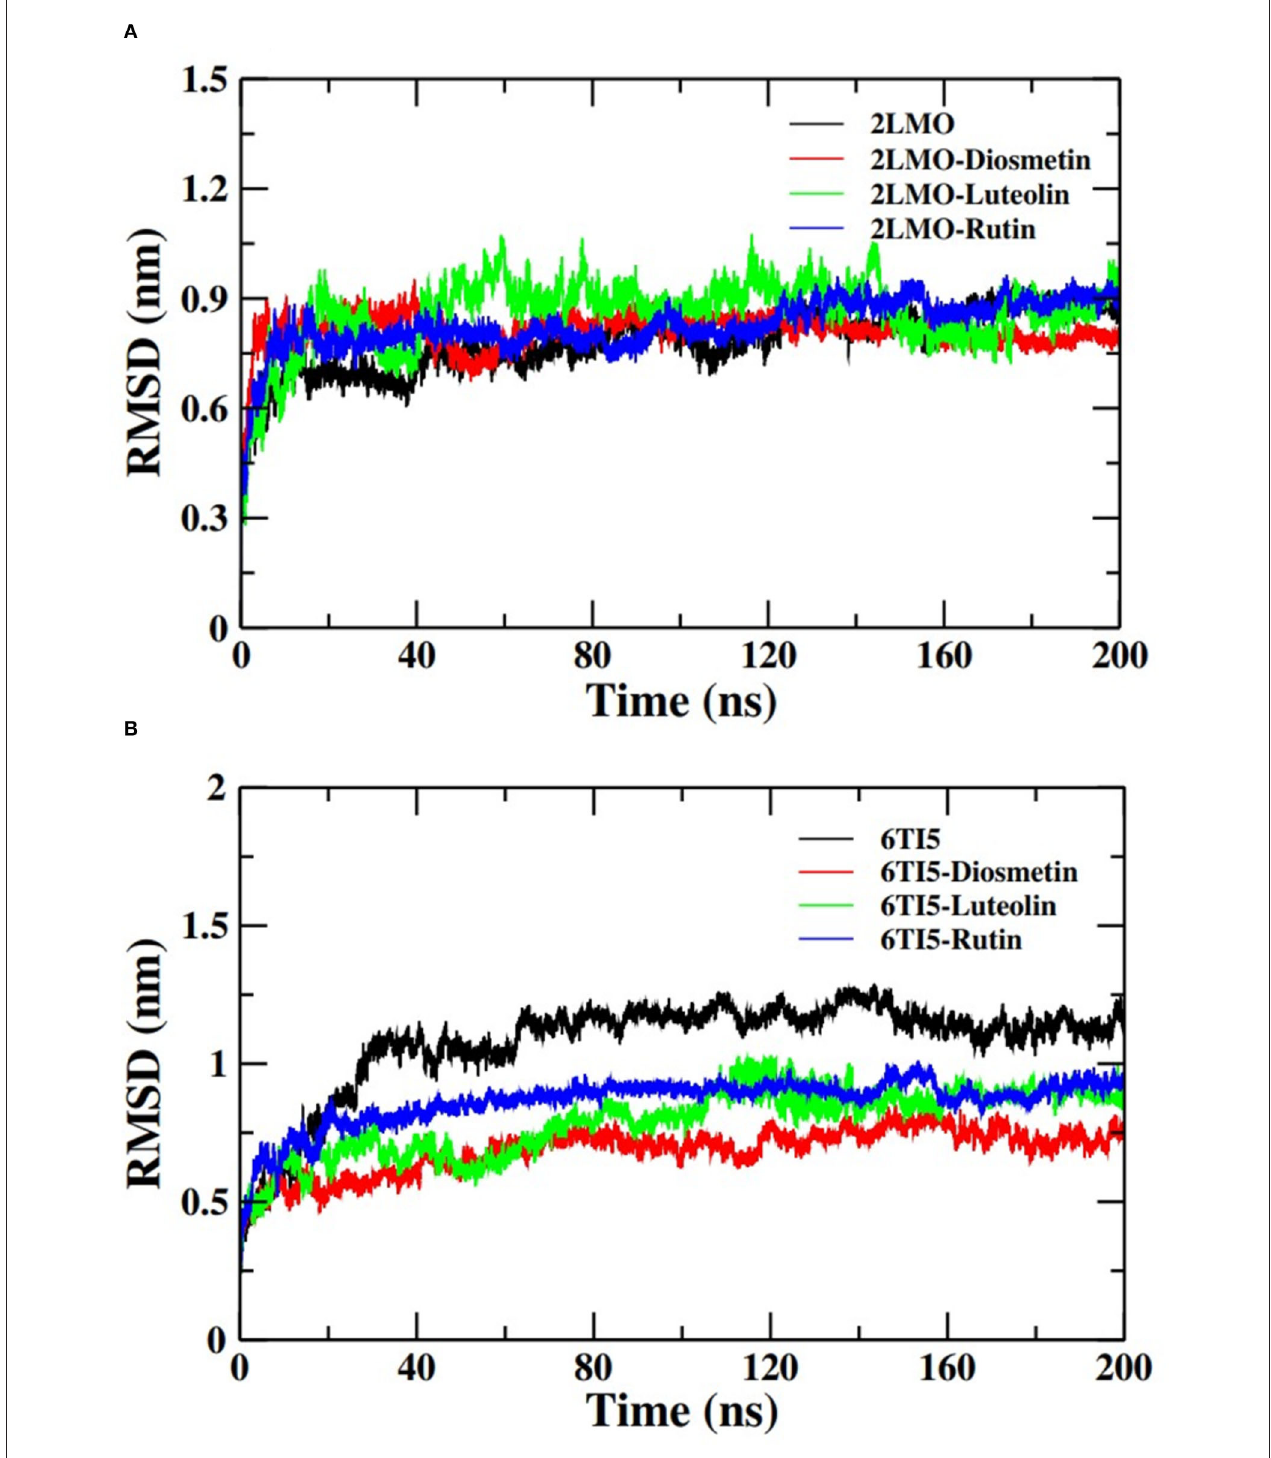
FIGURE 3 | Root mean square deviation (RMSD) of the backbone atoms of (A) 2LMO and its complexes with Diosmetin, Luteolin and Rutin and (B) 6TI5 and its complexes with Diosmetin, Luteolin and Rutin over 200 ns of MD simulation.